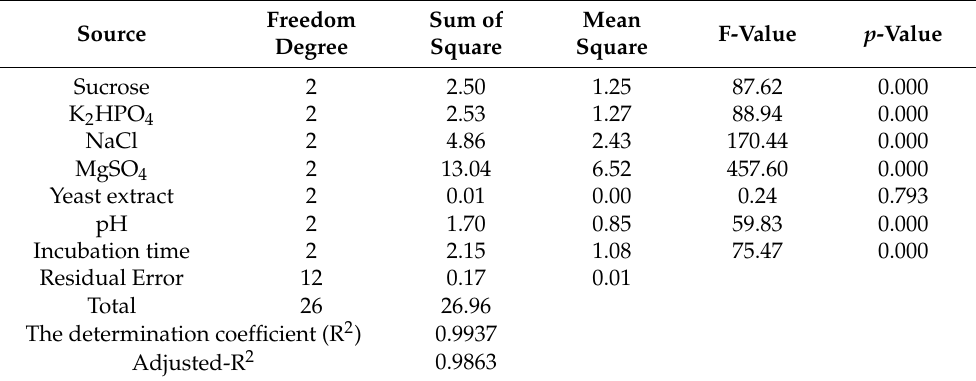
Table 2. ANOVA of means of pullulan biosynthesis by A. pullulans as affected by the seven investi- gated factors.